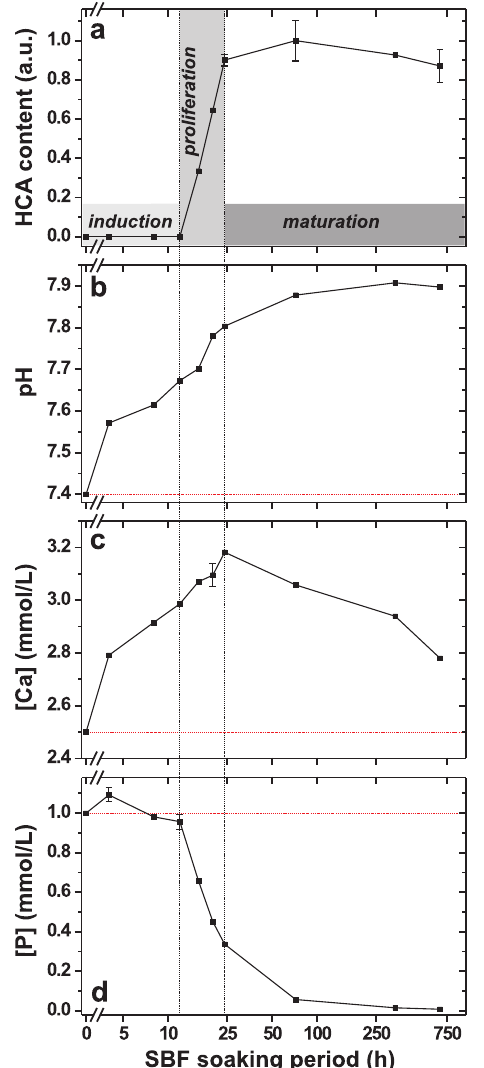
Figure 3. ( a ) IR-derived relative HCA contents in BG45 4.0 – τ SBF specimens plotted against τ SBF . ( b – d ) Results of ( b ) pH, ( c ) [Ca] and ( d ) [P] measured in the accompanying solutions. Note the usage of a logarithmic (log ) horizontal scale. The dotted vertical lines and the shaded domains 10 highlight the corresponding induction, proliferation, and maturation stages normally discussed in the context of spontaneous apatite formation, while red dotted horizontal lines in ( b – d ) indicate the respective values of the pH, [Ca] and [P] in the pristine SBF solution (i.e., for τ SBF = 0). Note that error bars are only displayed when outside of the symbols. The largest relative amount of HCA (observed at τ SBF = 72 h) corresponds to 29 ± 3 wt% HCA out of all solid